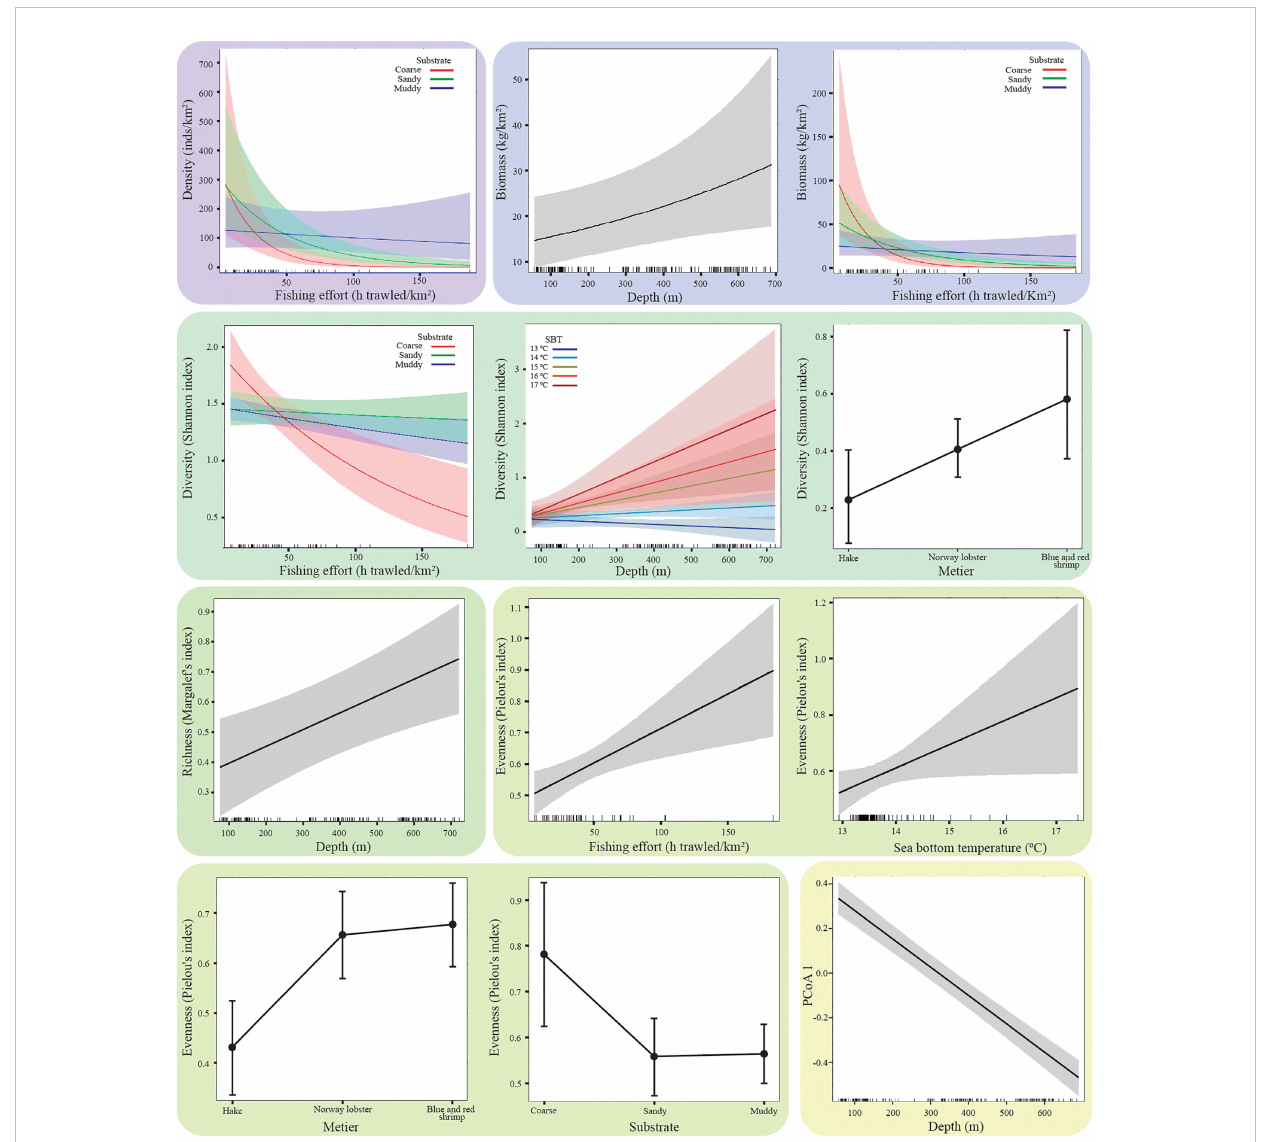
FIGURE 4 Partial effects of predictor variables included in the selected models for chondrichthyan density (inds/km 2 ), biomass (kg/km 2 ), diversity (Shannon index), richness (Margalef ’ s index), evenness (Pielou ’ s index) and the principal coordinate (PCoA) axis. The box of each plot is coloured referring to its respective response